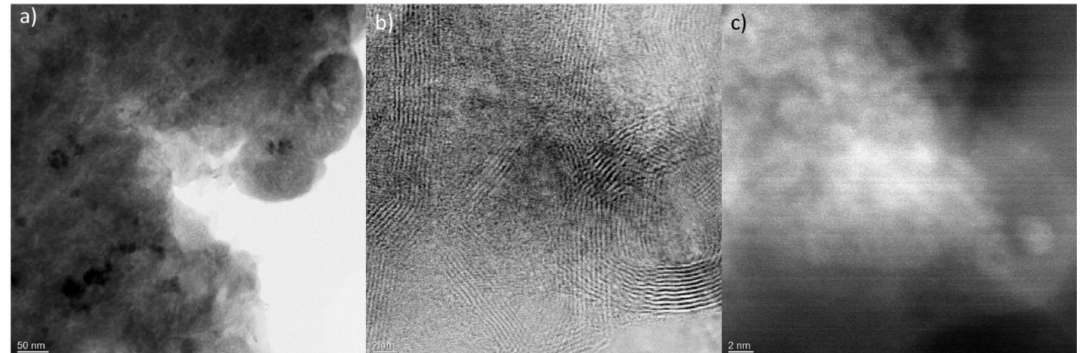
Figure 9. STEM images of sample after use. ( a ) Overview BF image showing a more compact structure of MWCNT; ( b ) HR-BF STEM image showing MWCNTs imbedded into amorphous material. ( c ) HAADF STEM image of the same area, as in ( a ), Pd redistributed in a network-like structure.